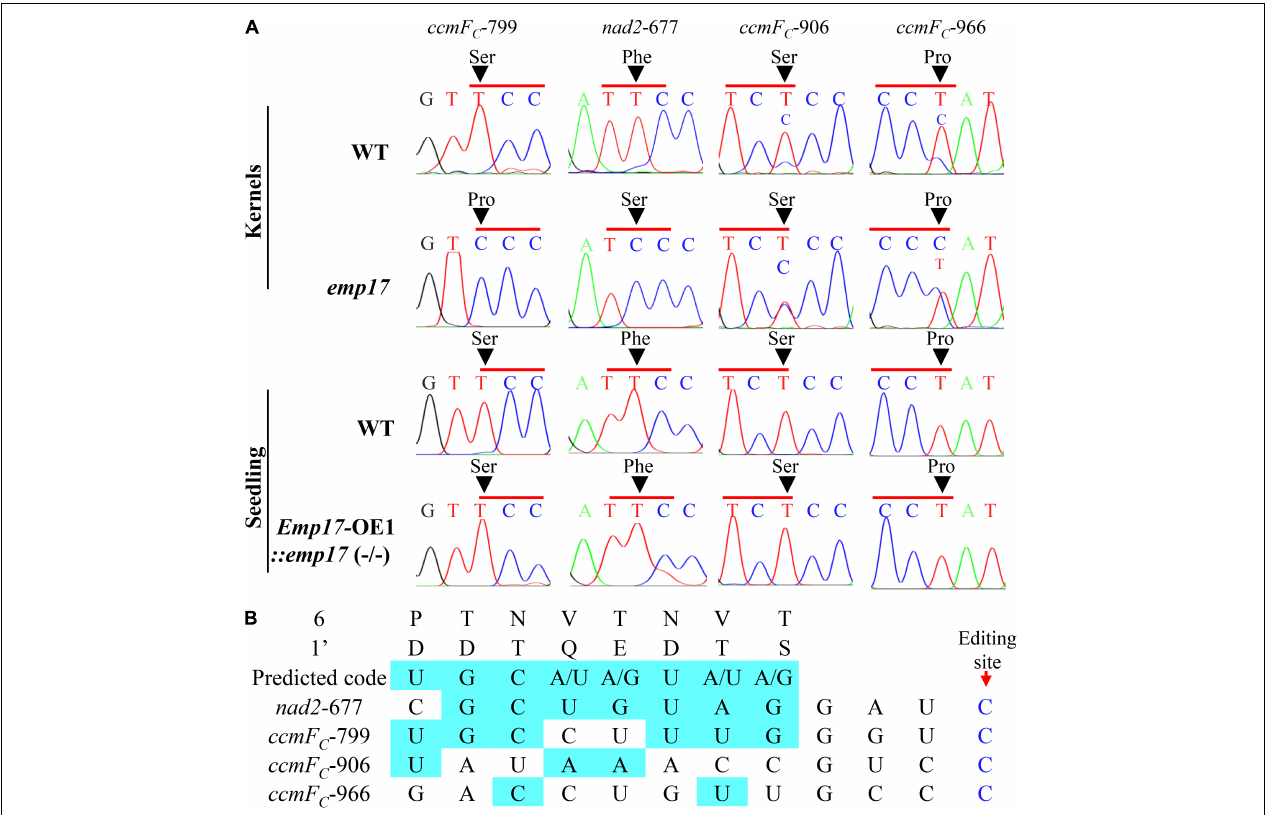
FIGURE 4 | Loss of function of EMP17 abolishes the editing at ccmF C -799 and nad2 -677 sites. (A) The defective editing sites in the emp17 mutant. Sites subject to defective editing marked by arrows. (B) Alignment of the amino acid residues at position 6 and 1 (cid:48) in each PPR motif of EMP17 with -4 to -11 bp upstream sequence of these four defective editing